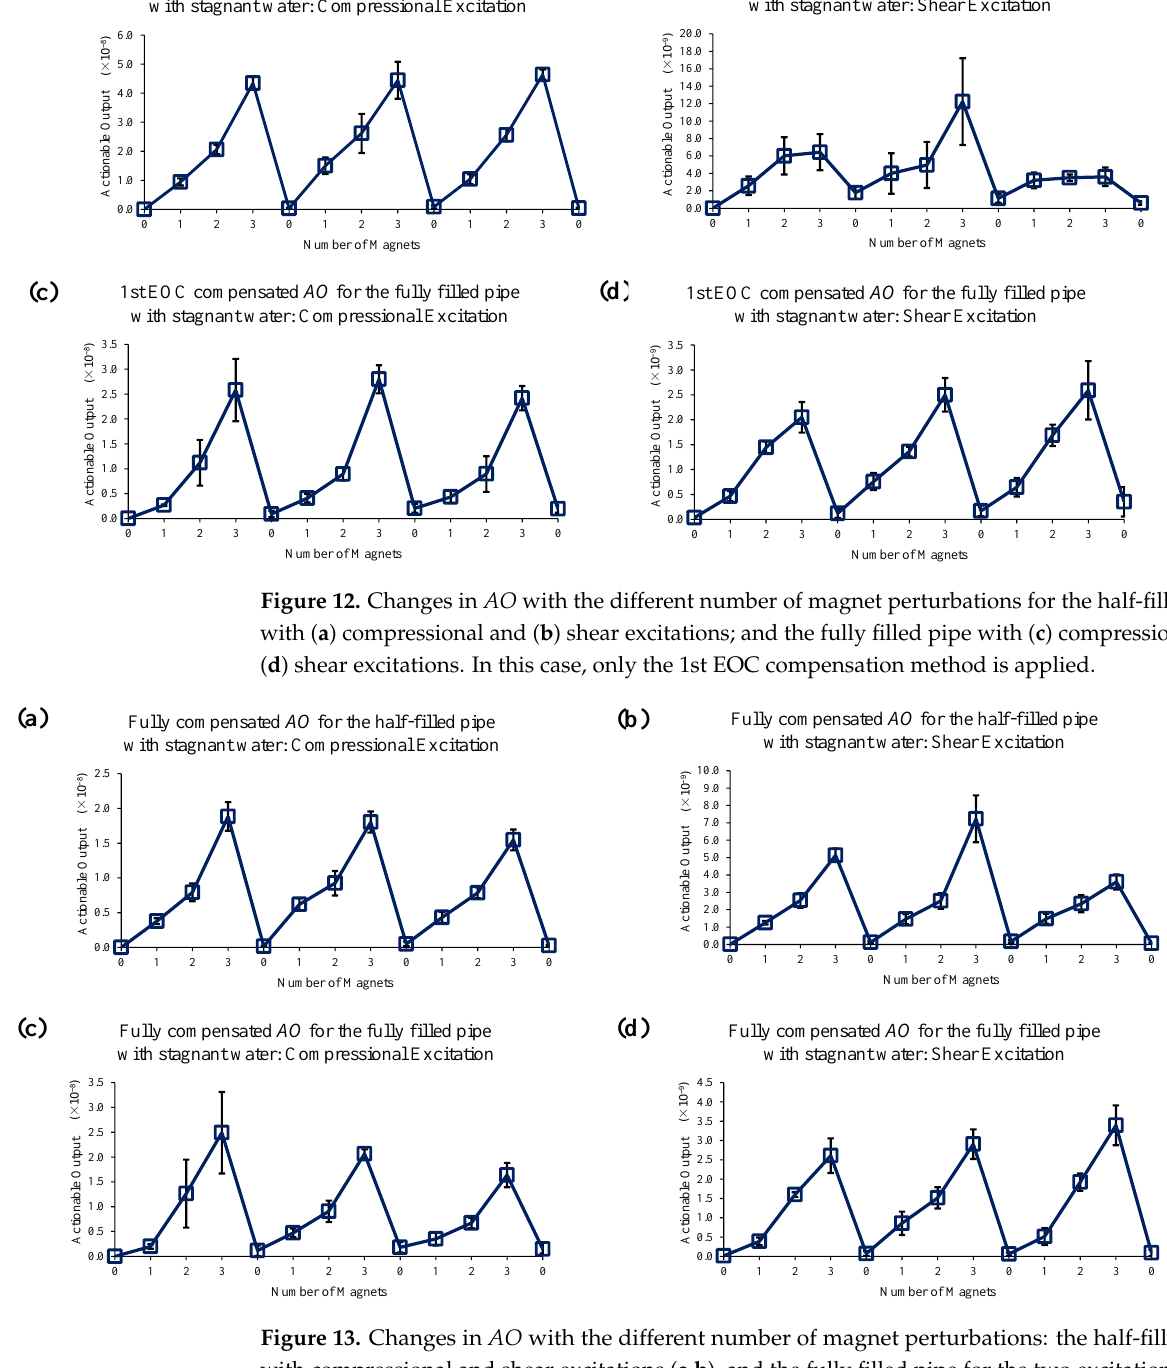
Figure 13. Changes in AO with the different number of magnet perturbations: the half-filled pipe with compressional and shear excitations ( a , b ), and the fully filled pipe for the two excitation modes ( c , d ). The full EOC compensation method is applied.